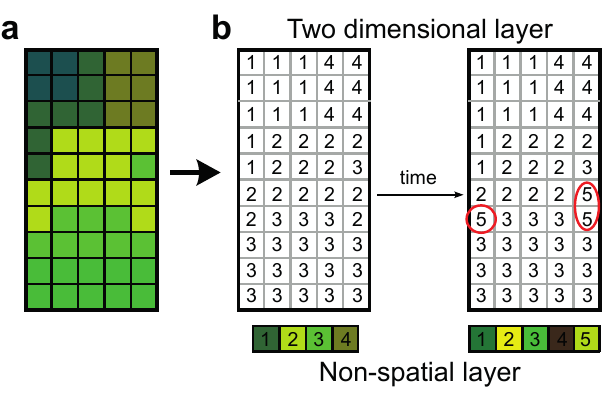
Figure 1. Visualisation of the dynamic two-layer classification con- cept. (a) Pre-defined similarity criteria (on abiotic drivers and bi- otic state variables) are used to classify similar grid cells to distinct types. Cells of the same type are coloured with the same shade of green. (b) For each type of cells one element is required on the non- spatial layer (coloured row, bottom). Cells on the two-dimensional layer (2-D-grid, top) are associated with these elements (numbers). Species’ compositions can change over time due to processes sim- ulated on both layers (changes in the coloured row). Furthermore, associations between the layers can change (changed numbers high- lighted by red circles), for example when processes simulated on the spatial-layer (e.g. seed dispersal) lead to differences among cells associated with the same element that violate one of the similarity